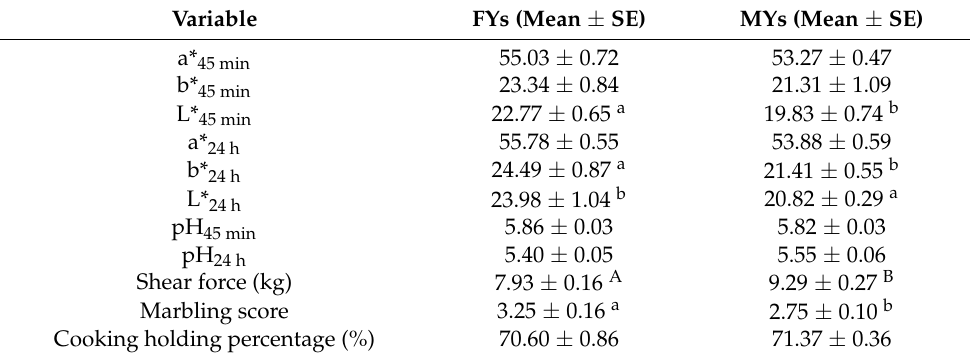
Table 1. The meat quality of longissimus dorsi (LD) in female (FYs) and male yaks (MYs). Variable FYs (Mean ± SE) MYs (Mean ± SE) a* 45 min 55.03 ±